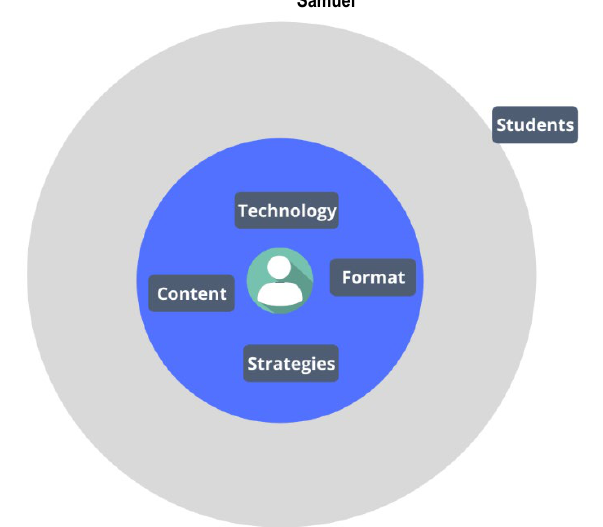
Figure 3. An adaptation of the Zones of Agency for Online Instructors model to depict a teaching environment where instructors have a high degree of